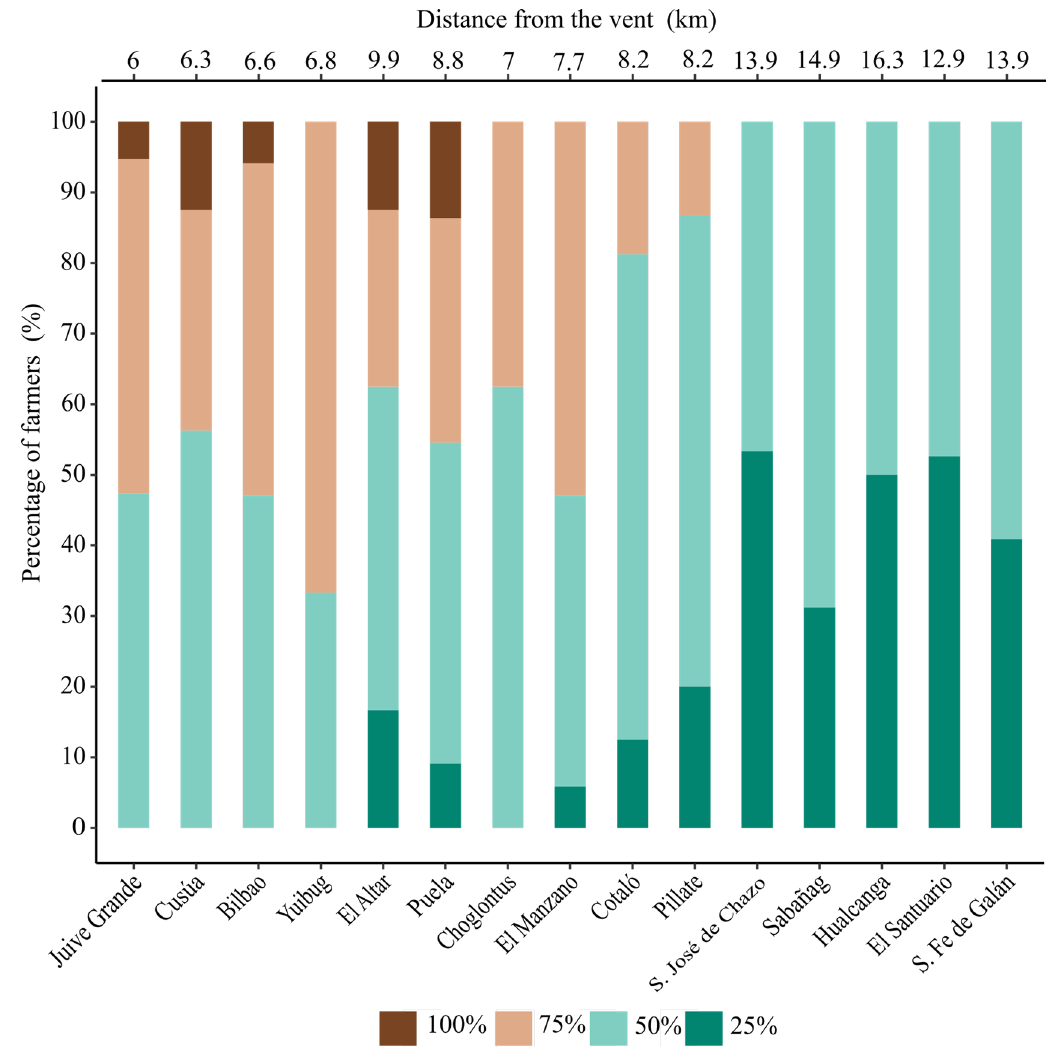
Figure 3: Percentage of farmers in each of the 15 villages surveyed who estimated a crop yield reduction x for the period 1999–2014 of 0 < x < 25, 25 ≤ x < 50, 50 ≤ x < 75, 75 ≤ x < 100 and 100 %. Distance of the village from the vent is also